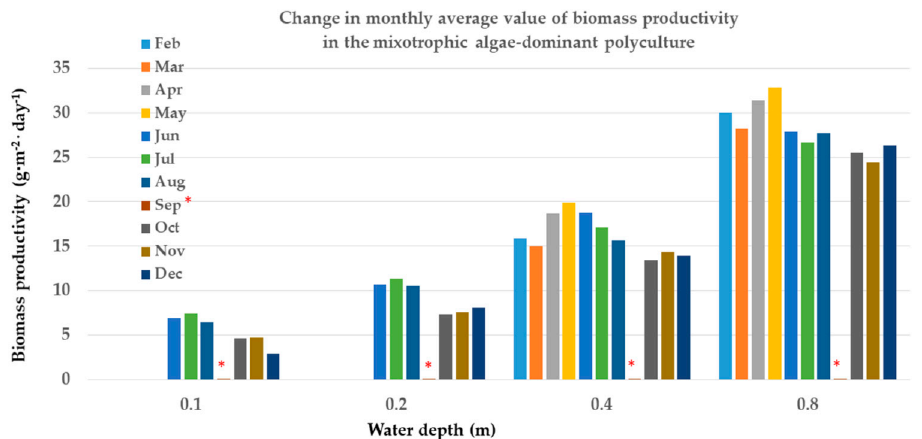
Figure 1. Biomass productivity in culture vessels with different water depths (September–December data added to Demura et al. [14] showing data from February to August. * September data missing due to flood